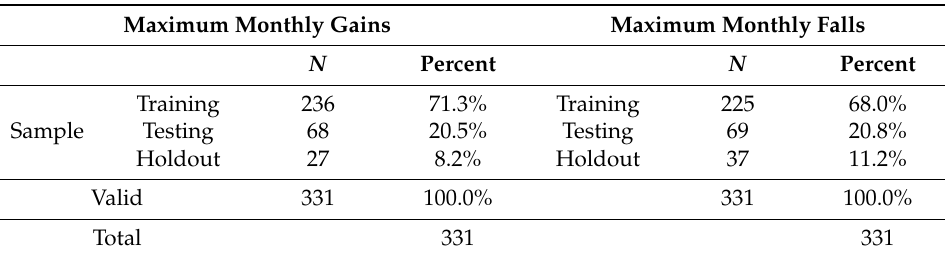
Table 6. Network model summary for GSE maximum monthly gains and falls.